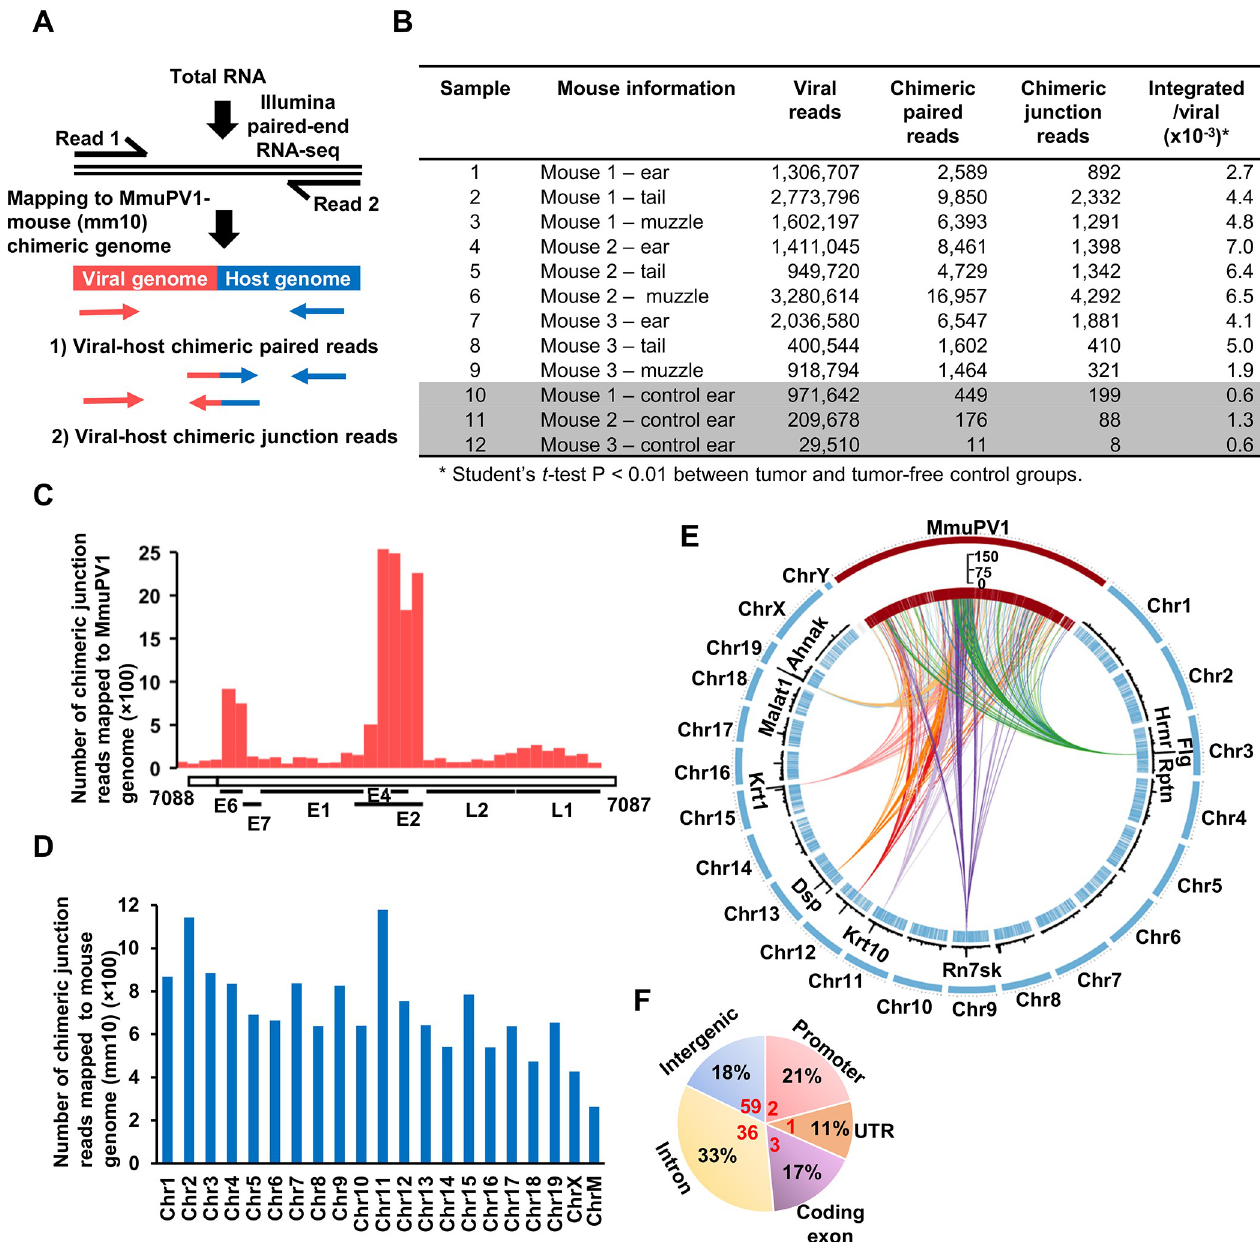
Fig 2. RNA-seq analyses of MmuPV1 integrations in mouse tumor and tumor-free tissues. A, Diagrams of the two principal types of chimeric RNA reads that derive from a viral integration site. Chimeric paired-end reads obtained in RNA-seq analysis were mapped to the MmuPV1 reference genome (NC_014326) and the mouse reference genome (mm10). The virus-host chimeric paired reads are defined by one read that fully maps to the virus genome and the other read that fully maps to the host genome. A virus-host chimeric junction read (CJR) is a read that contains the virus-host junction that links sequences in the virus genome and the host genome independent from RNA splicing. B, The number of chimeric RNA reads from tumor tissues from three distinct MmuPV1-inoculated anatomical sites (ear, tail and muzzle) of three separate female mice. The left ear (without MmuPV1 inoculation) was from the same animal, which had a normal appearance, and served as a normal control for total RNA extraction and RNA-seq analysis. C, Distribution of mapped integration breakpoints (CJRs) across the MmuPV1 genome in nine tumor samples. D, Chromosomal distribution of the mapped integration sites in the mouse genome based on the CJRs ChrM, mitochondrial chromosome. E, Distribution of the MmuPV1 integration events across the mouse genome. The outer circle represents the locations of the viral genome (MmuPV1, red) and the 20 mouse chromosomes (chr, blue). The sizes of mouse chromosomes are proportional to their lengths, and the viral genome is scaled up 100,000x. Each “tick” in internal circle indicates a detected integration event. The black bars in the middle depict the frequency of the MmuPV1 integration events in each region and the 9 genes with the highest number of integration sites are highlighted. The circular diagram was created using Circos package (doi:10.1101/gr.092759.109). F, Pie chart showing percent distribution (% in black) of the mapped RNA CJRs in the different genomic regions. Numbers in red are the normal fraction (%) of each region in the mouse genome. The CJRs (integration sites) were annotated using the annotate Peak command of ChIPSeeker (doi:10.1093/bioinformatics/btv145) package.